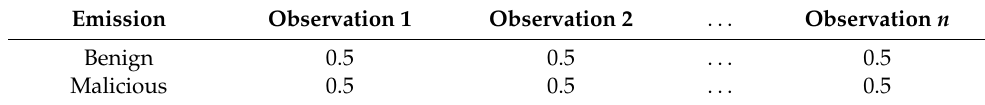
Table 4. Initial emission